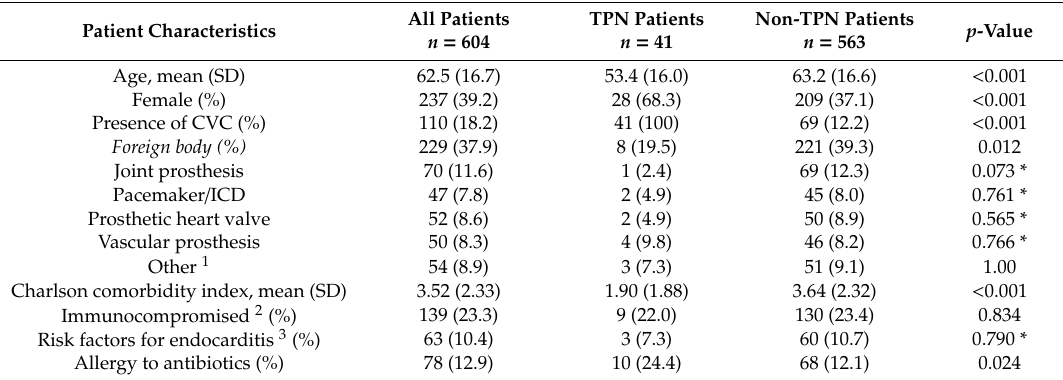
Table 1. Comparison of patient characteristics.